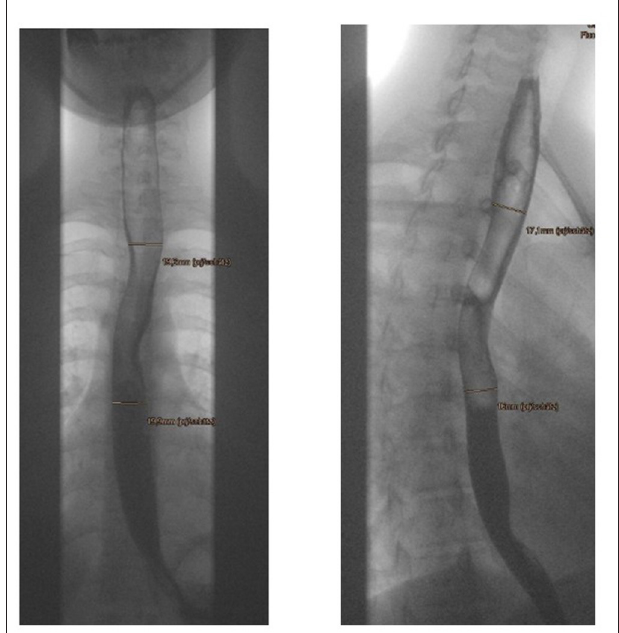
FIGURE 1 | Upper and lower measuring points in both